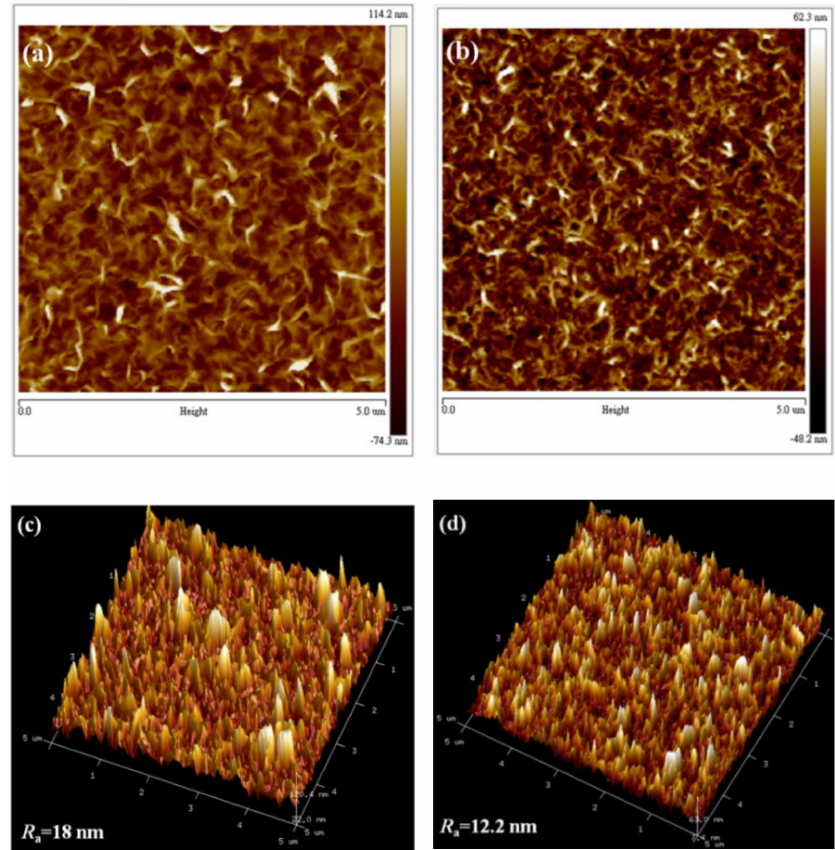
Figure 3. AFM topographic and 3D images of the ( a , c ) undoped and ( b , d ) Ni-doped ZnO